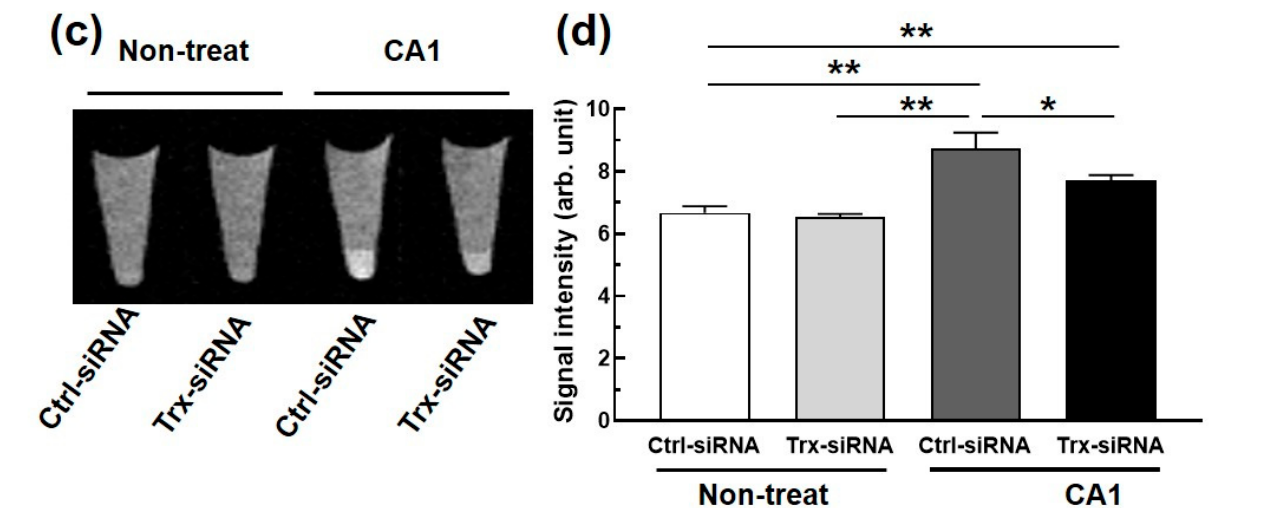
Figure 5. ( a ) Western blot analyses of Trx expression levels in MCF-7 cells transfected with Trx-siRNA (3 µM, 48 hrs) compared to those of control siRNA (Ctrl-siRNA) and ( b ) a corresponding quantitative comparison of Trx expression (n = 2). ( c ) A representative T 1 -W MR phantom image of MCF-7 cells transfected with Trx-siRNA or Ctrl-siRNA and then treated with CA1 (100 µ M) at 200 MHz at room temperature, and ( d ) a comparison of the corresponding signal intensities (n = 3). *, p < 0.05; **, p < 0.01 (Student’s t-test ).